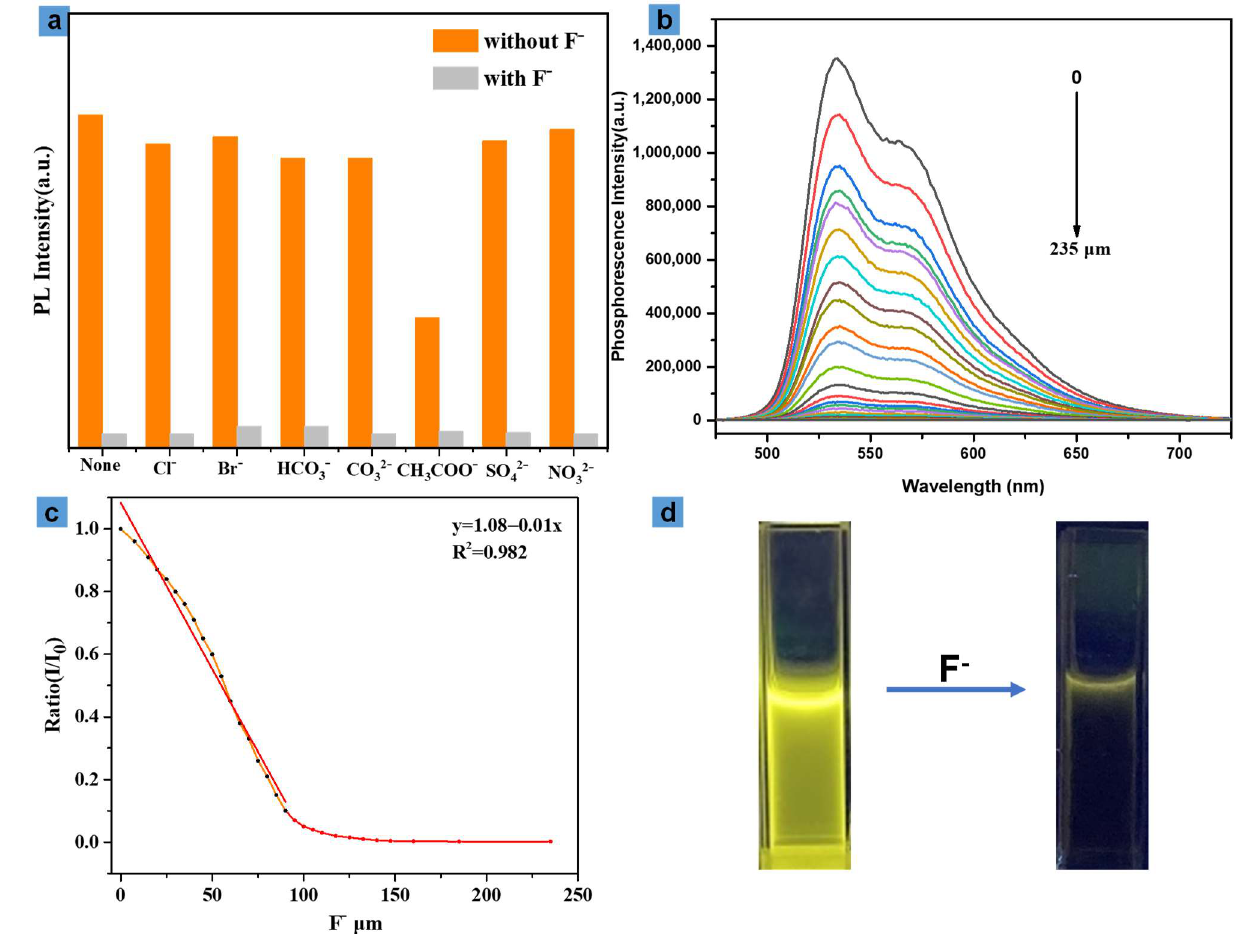
Figure 3. ( a ) the emission intensity of complex 4 in dichloromethane with other anions in the absence or presence of F − at 30 °C; ( b ) The emission spectra for the response of complex 4 to fluoride anion in dichloromethane; ( c ) the plot of phosphorescent intensity ratio (I/I 0 ) to the concentrations of fluoride anion, monitored at 535 nm; ( d ) the photographs of the solution before and after the addition of fluoride anion.